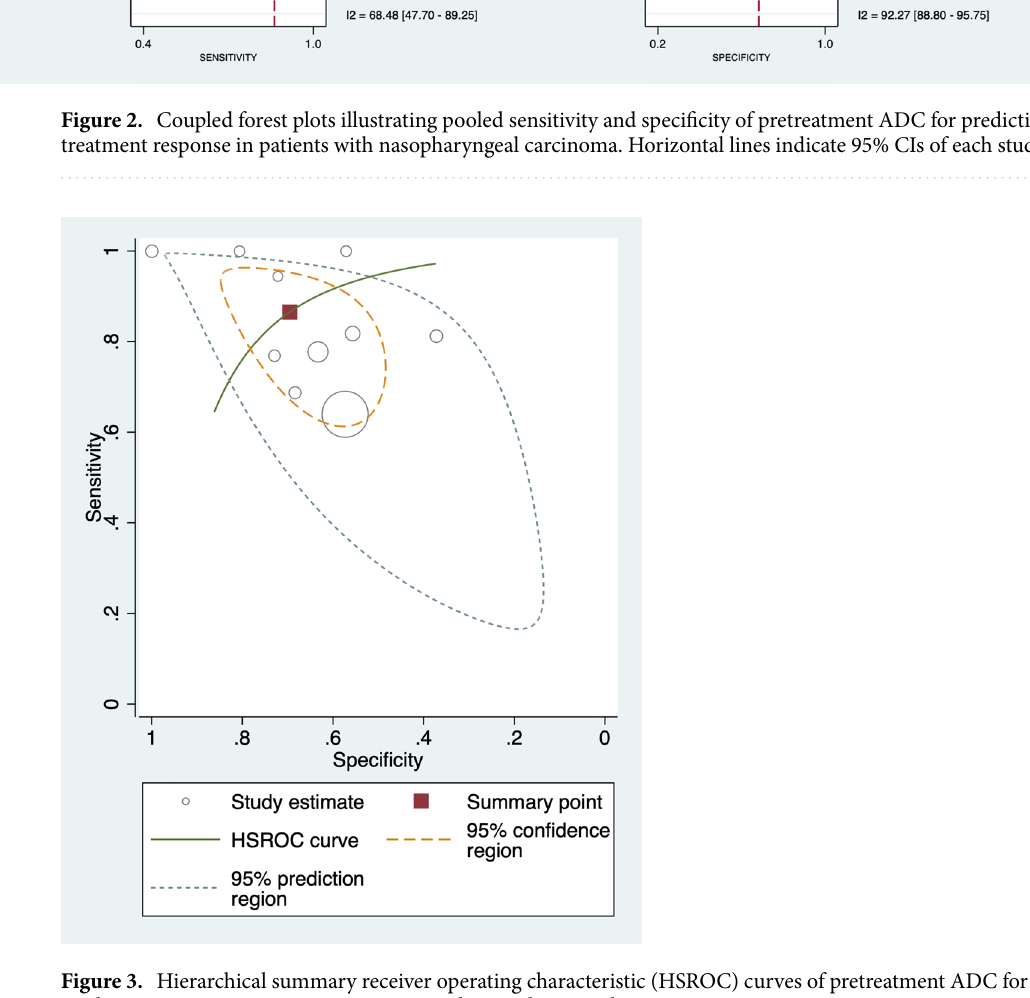
Figure 3. Hierarchical summary receiver operating characteristic (HSROC) curves of pretreatment ADC for predicting treatment response in patients with nasopharyngeal